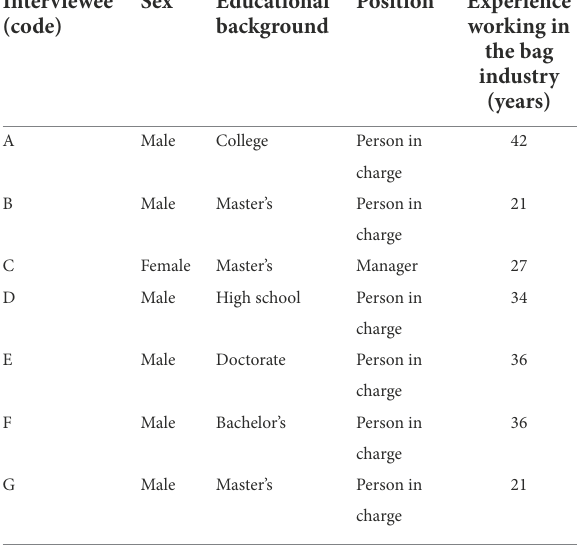
TABLE 3 Individual background and experience of each interviewee. Interviewee